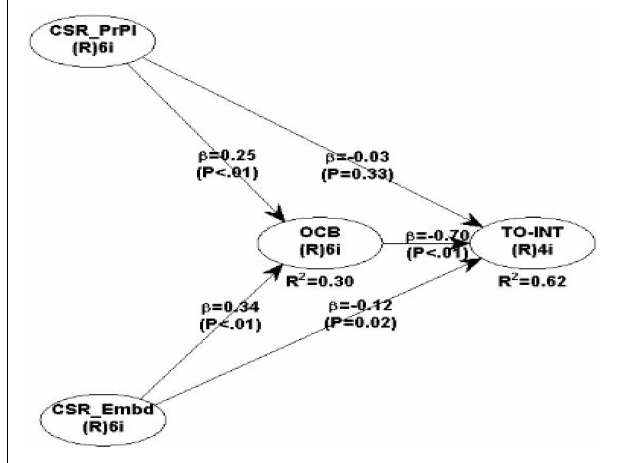
FIGURE 2 | Research framework with path coefficients and corresponding p